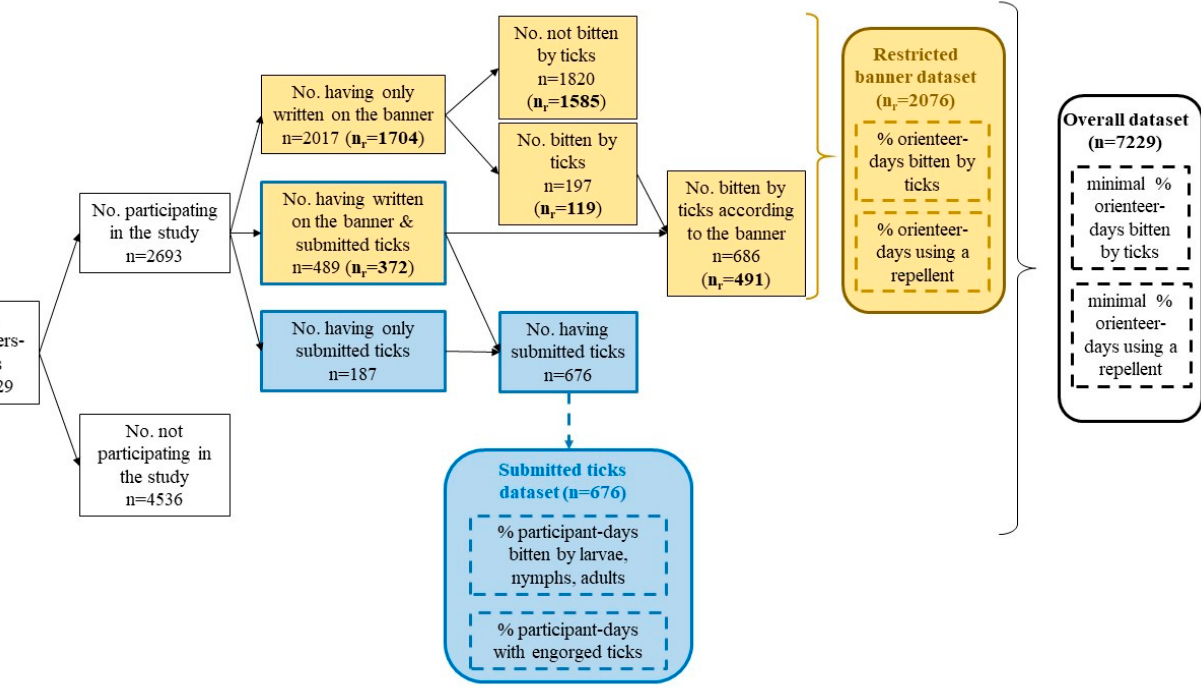
Figure 2. Description of the different groups that were created from the orienteers for the different analysis. An orienteer-day refers to one orienteer during one day, without considering if the orienteer participated in the study on another day. We differentiated data from the giant banner (in yellow) and data from the biting ticks submitted at the end of each racing round (in blue). Dotted lines indicate parameters estimated from our analysis; straight lines indicate parameters directly measured. n r refers to the banner-restricted dataset: orienteers who participated at least four times in the study.